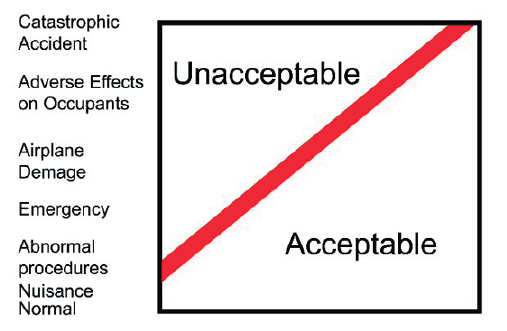
Fig. 1. FAA AC 25.1309 Probability vs. consequence